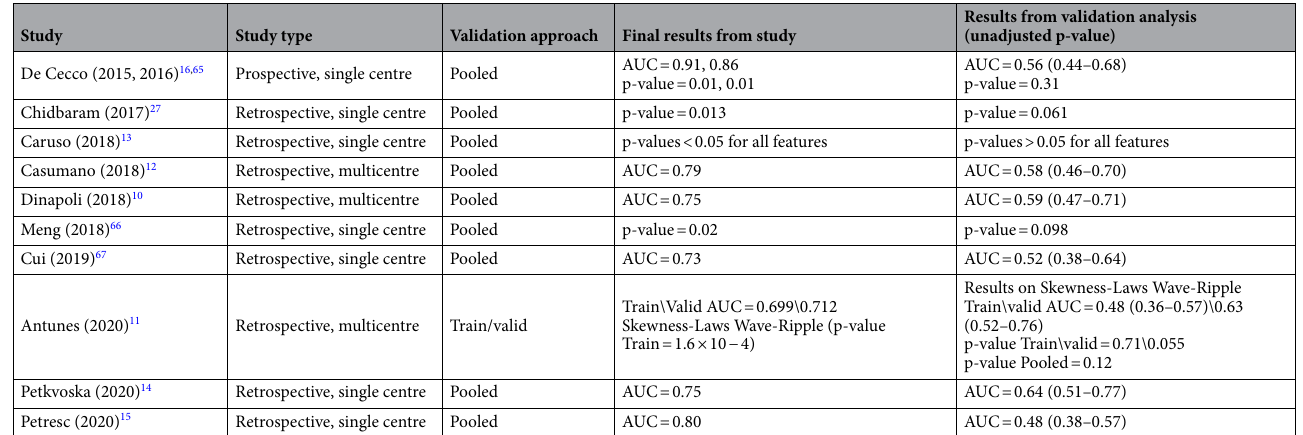
Table 4. Overview of studies included in validation analysis. For all included studies, patients were treated with nCRT followed by resection. Radiomics analysis was reported on pre-treatment T2w MRI with features extracted from the primary tumour region. The column validation approach indicates whether model coefficients or statistical tests were applied on the pooled training and validation data (Pooled) or the model was re-trained on the training data and validated on the validation data (train/valid). AUC area under a curve (with 95% confidence interval in brackets), MRI magnetic resonance imaging, nCRT neoadjuvant